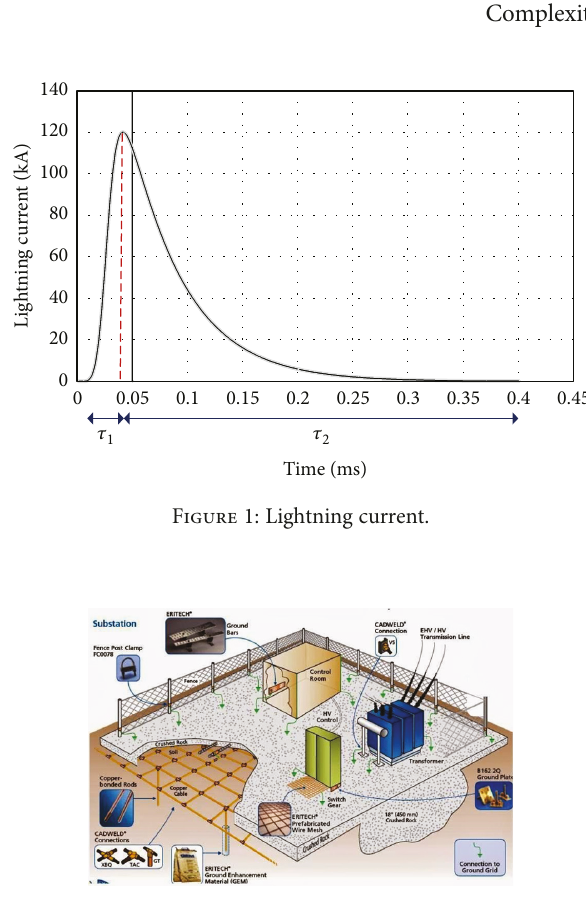
Figure 2: General arrangement of an earth electrode system at an electrical substation